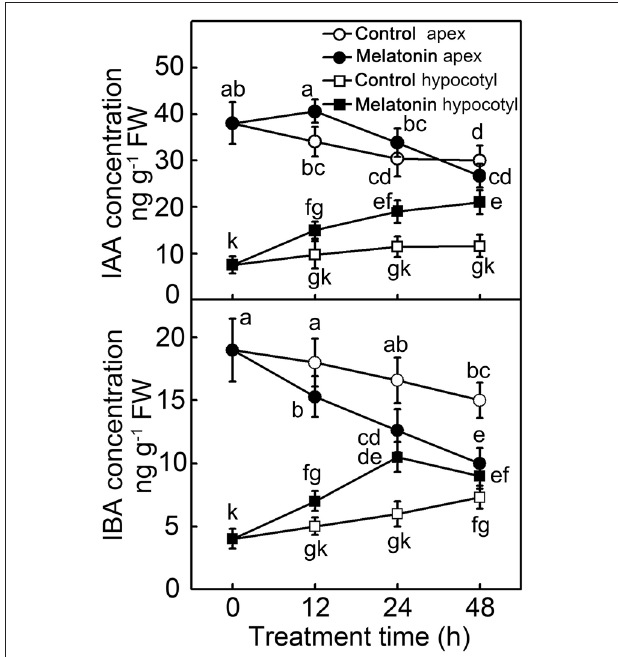
FIGURE 3 | Concentration of IAA and IBA during the MT-induced adventitious root development. The primary system was removed from hypocotyls of 10-days-old tomato seedlings. Explants were incubated with water (Control) and 50 µ M MT (MT). Data represent the means of five replicates ± SD, and different letters indicate significant difference ( p < 0.05).